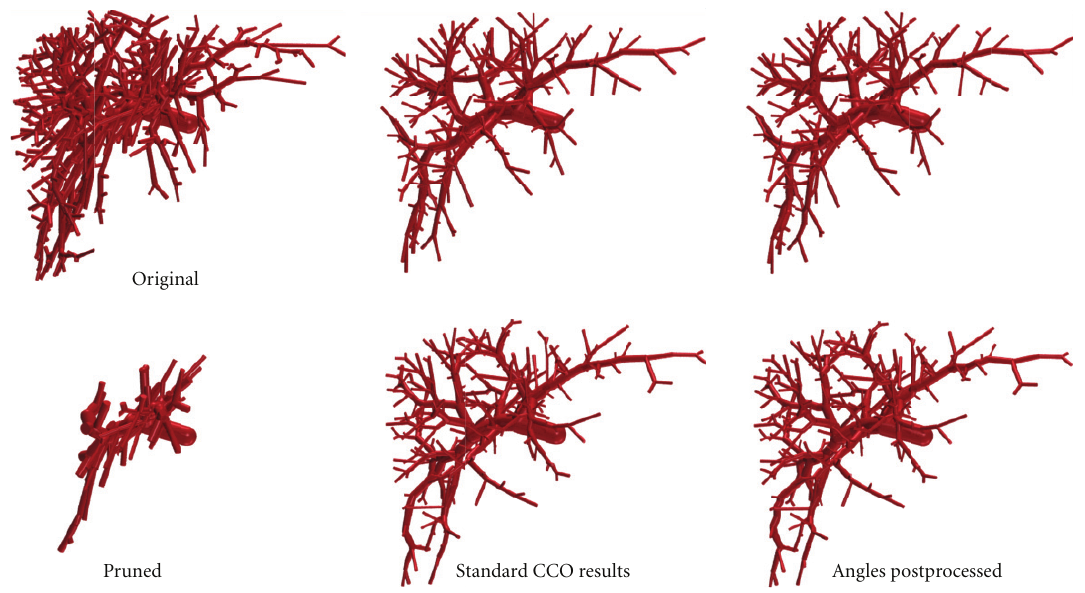
Figure 4: For the “dense” example in Figure 2, the (a, d) shows the preprocessed clinical PV tree before (a, b, c) and after (d, e, f) pruning to the coarse anatomic structures. Two resulting CCO trees before and after angle postprocessing are shown in the (b, e) and (c, f), respectively.